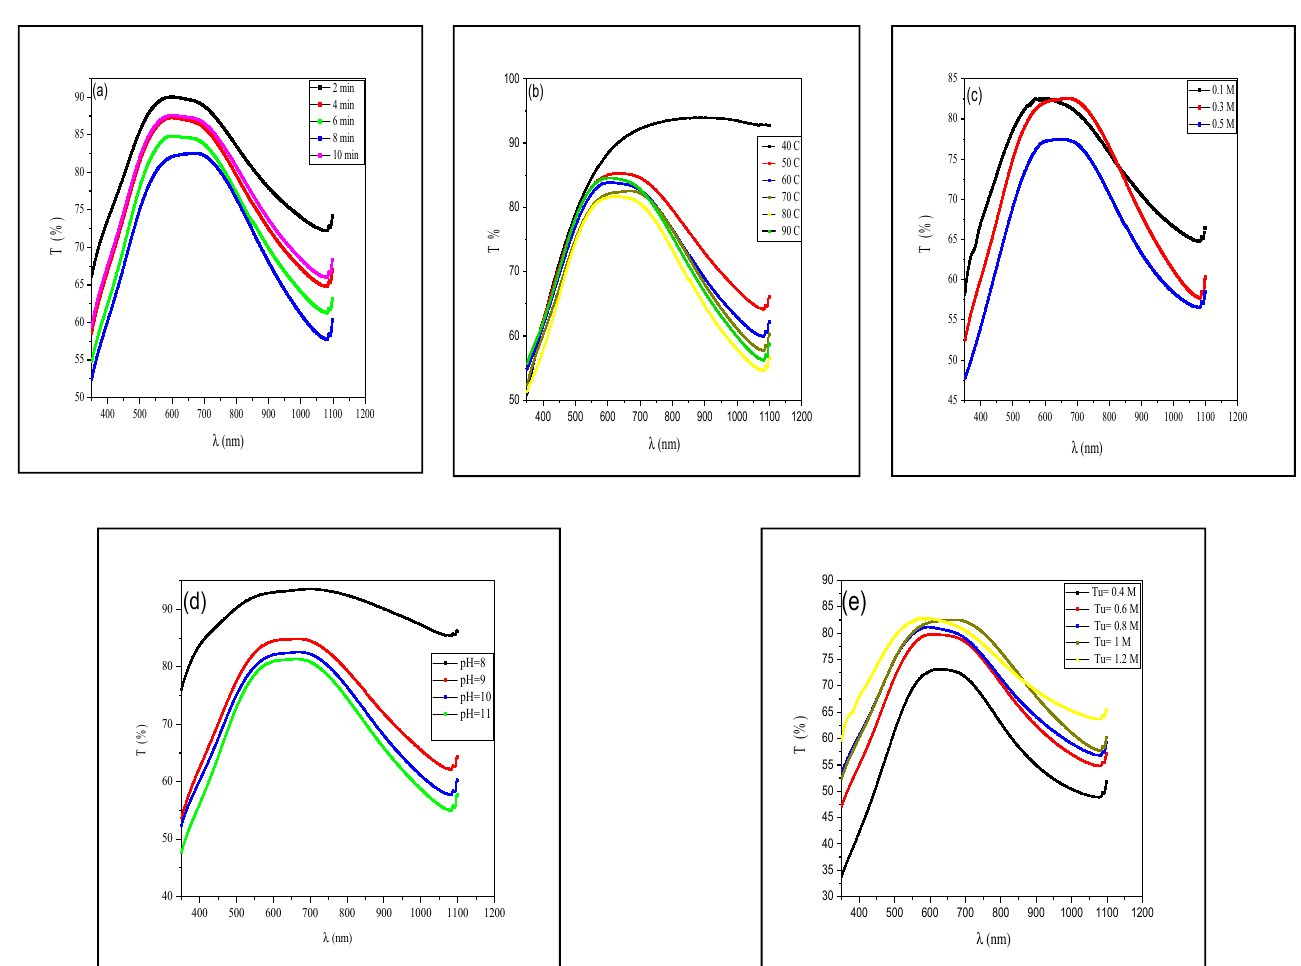
Figure 4. Transmission spectrums of Cu 2 S thin films as a function of different deposition parameters: ( a ) Deposition time, ( b ) bath temperature, ( c ) CuSO 4 .5H 2 O concentration, ( d ) pH value, and ( e ) SC (NH 2 ) 2 concentration.